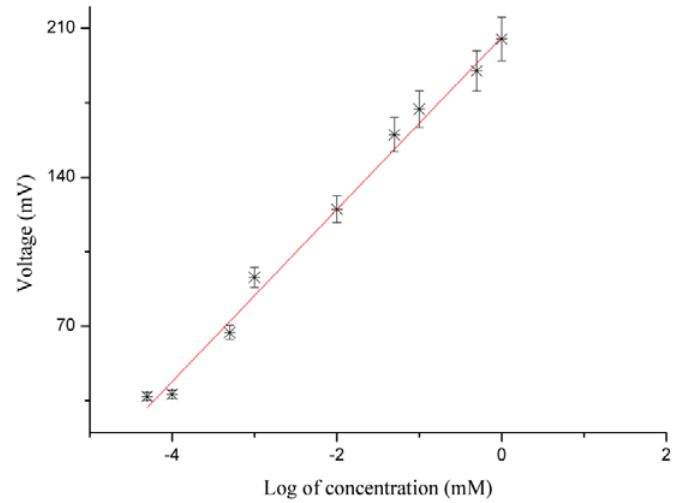
Figure 2. Calibration curve of lactate oxidase immobilized ZnO nanorods biosensor for L -lactic acid concentration 1 × 10 − 4 to 1 × 10 0